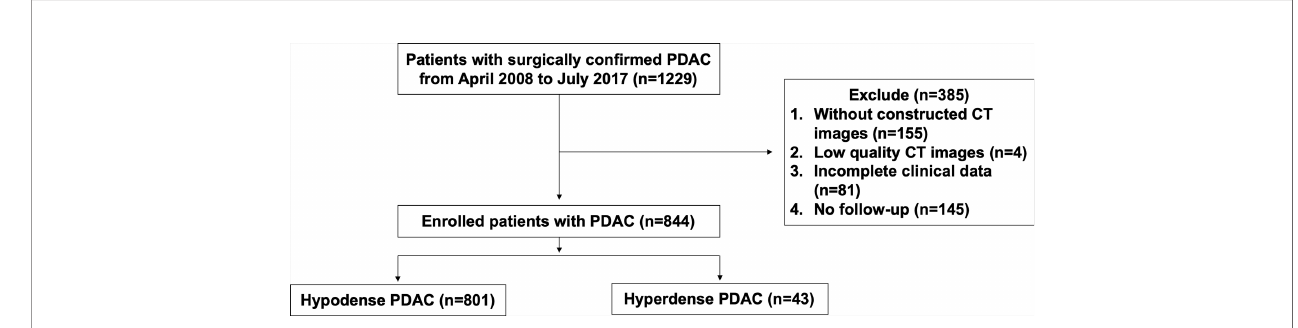
FIGURE 1 | Flow diagram of patient